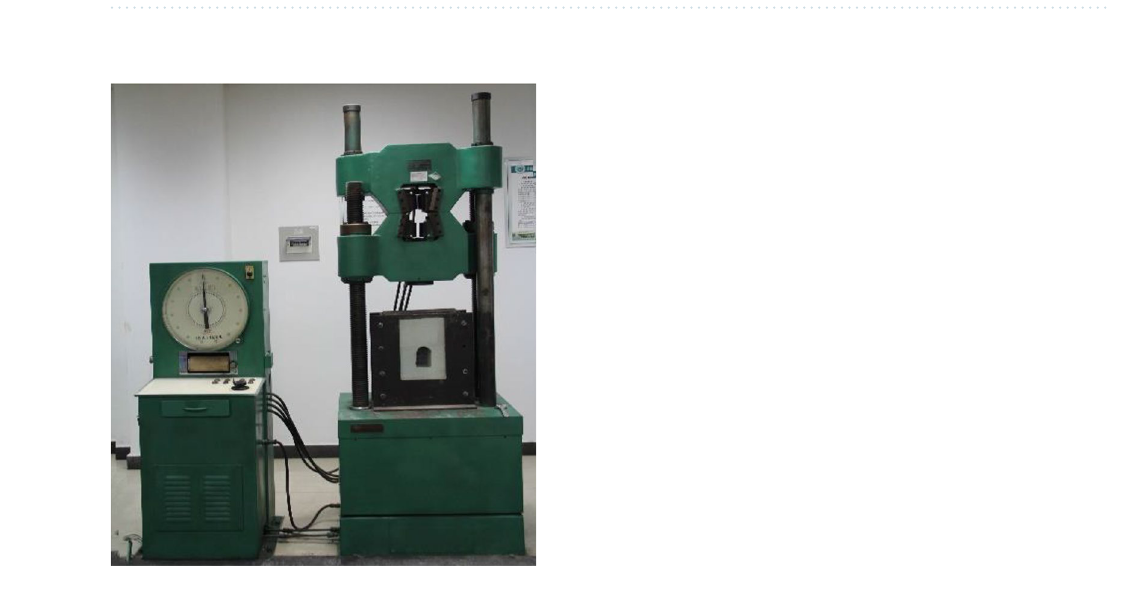
Figure 2. Photo of the universal testing